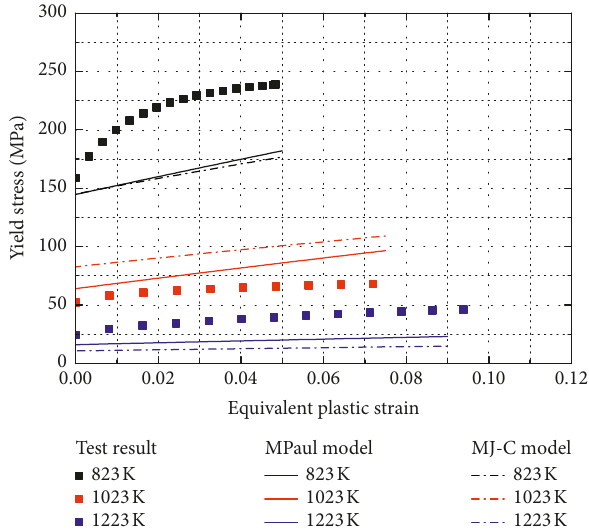
Figure 6: Flow curve at different